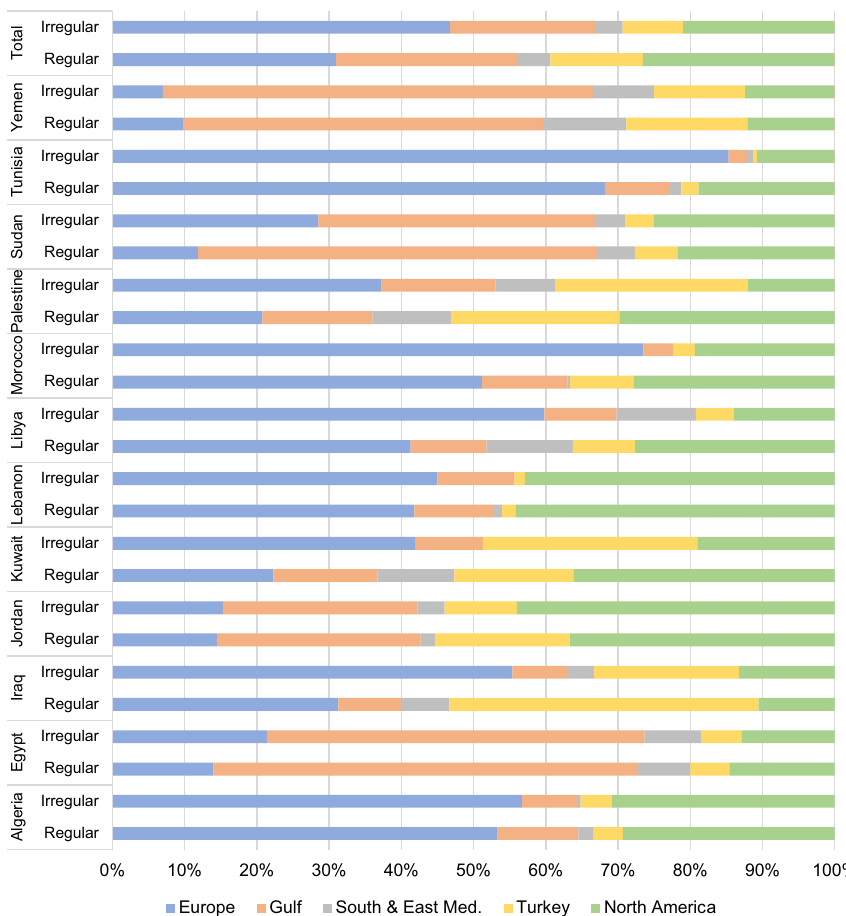
Fig. 5 Desired destinations of those wanting to emigrate, by country and irregularity willingness. Notes: stacked to 100%, “Which country are you thinking of emigrating to?”, respondents were able to make more than one choice. Source : Arab Barometer V, weighted